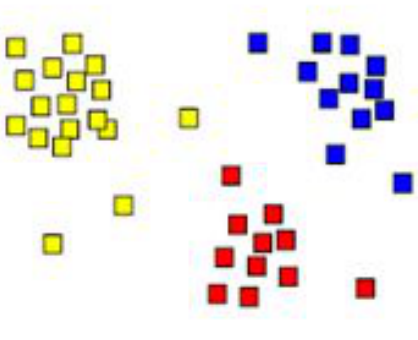
Figure 3: Clustering